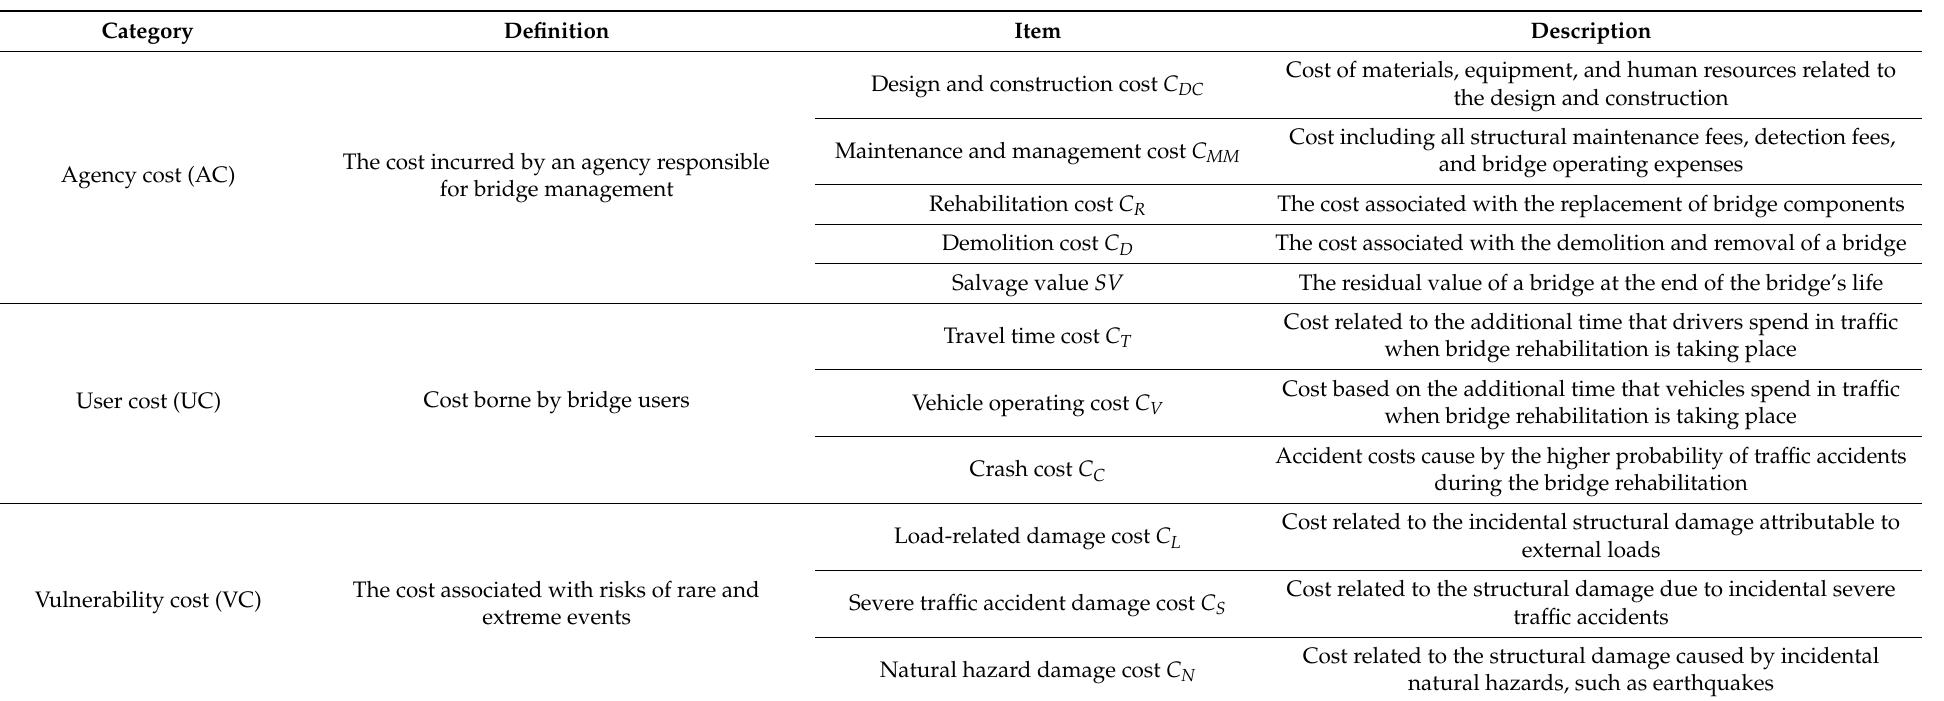
Table 1. Categories of bridge life-cycle cost